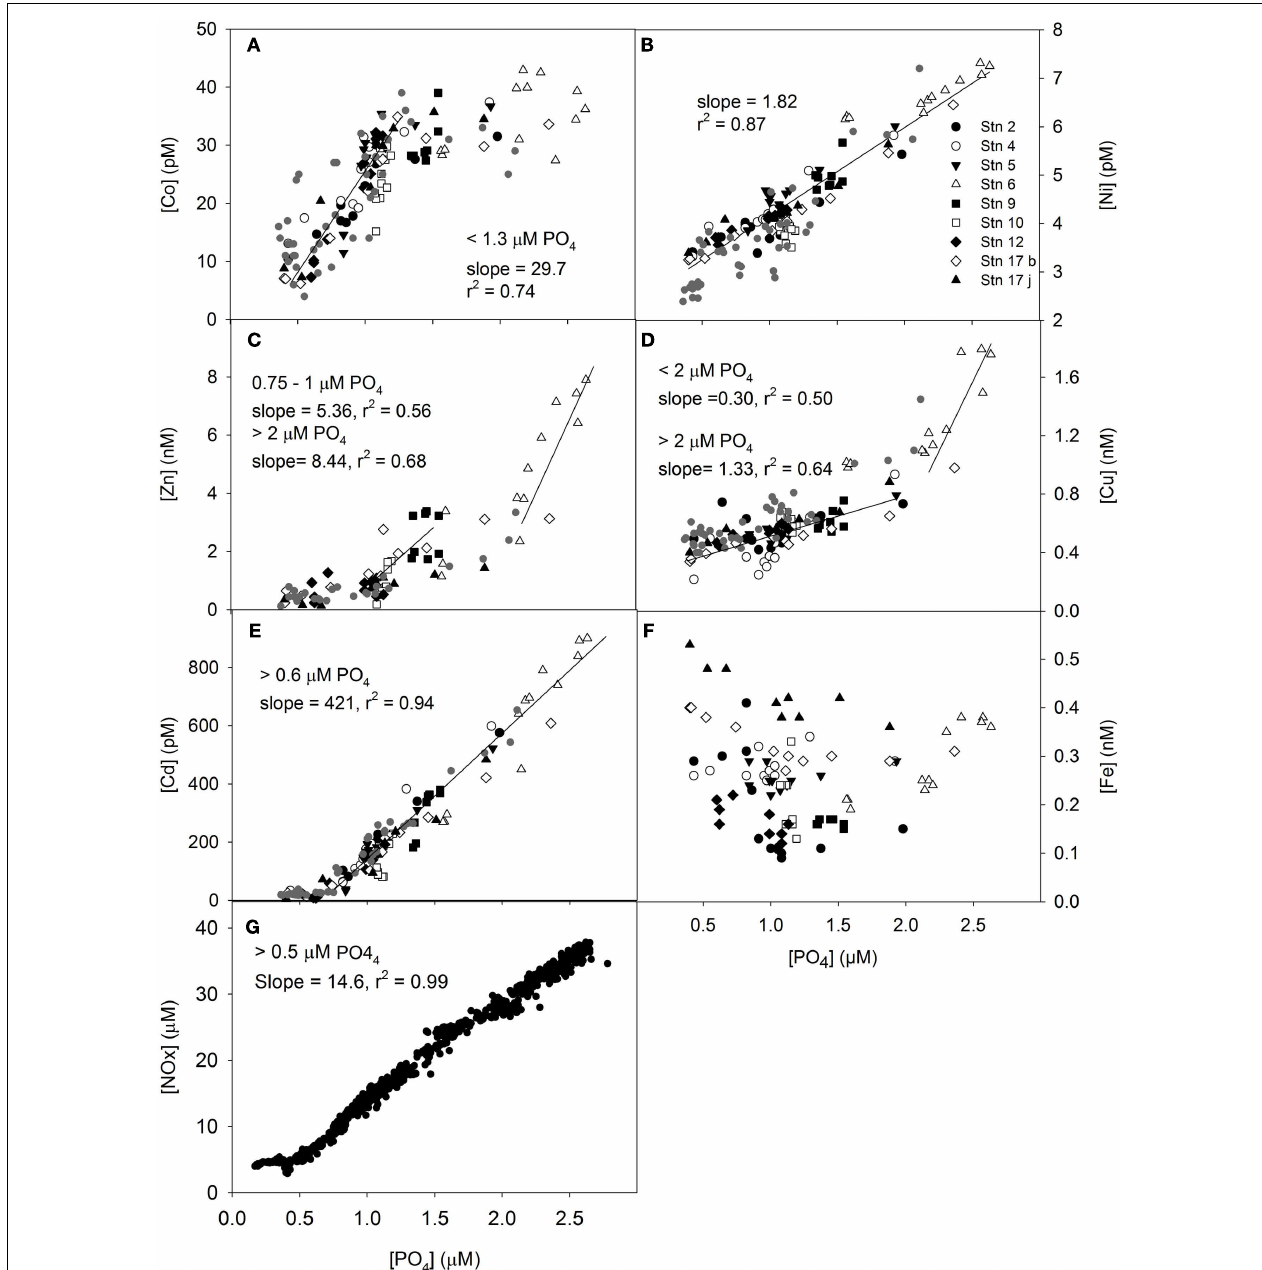
with their coefficient of correlation and slope. Stations are represented by different symbols. Data from a previous study in the region are also shown (Ellwood, 2008). Data for dissolved iron are from Lannuzel et al.